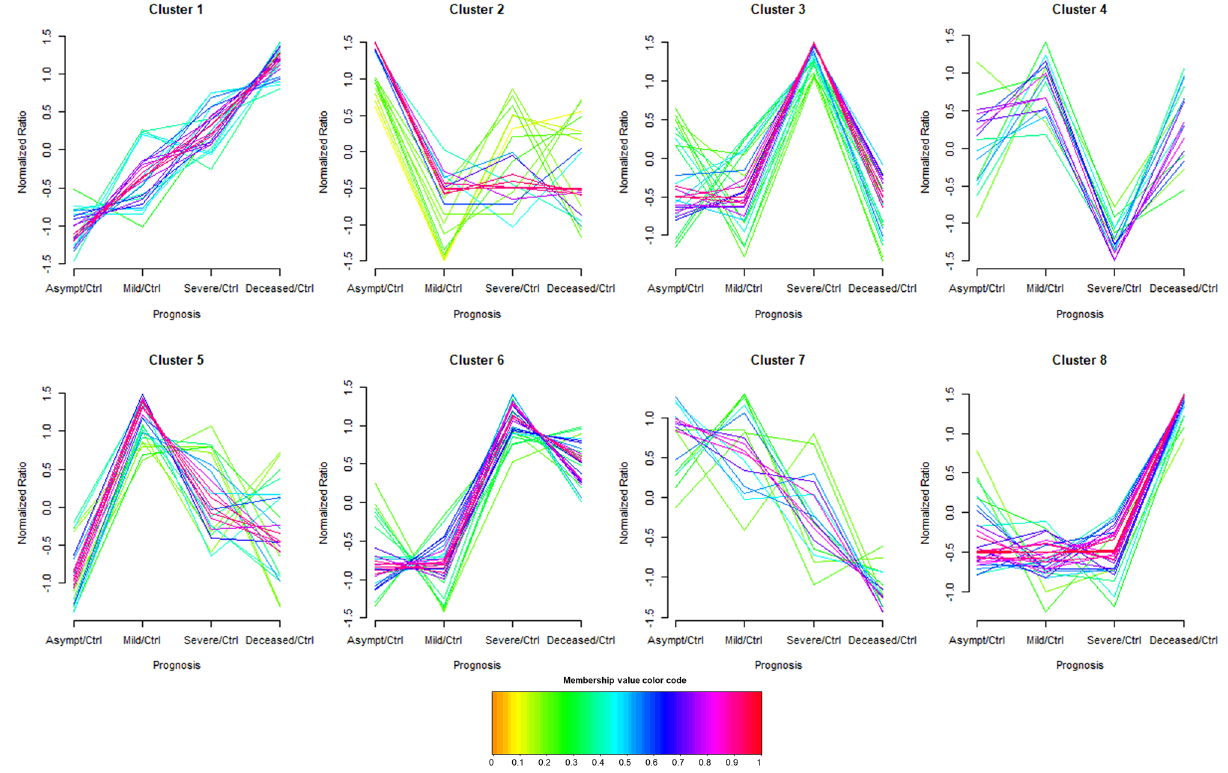
Figure 2. Fuzzy c-means clustering patterns of metabolite ratios between COVID-19 positive patients (asymptomatic, mild, severe and deceased) and non-COVID-19 control patients (Ctrl). Each trace is colour coded according to its membership value for the respective cluster (see colour